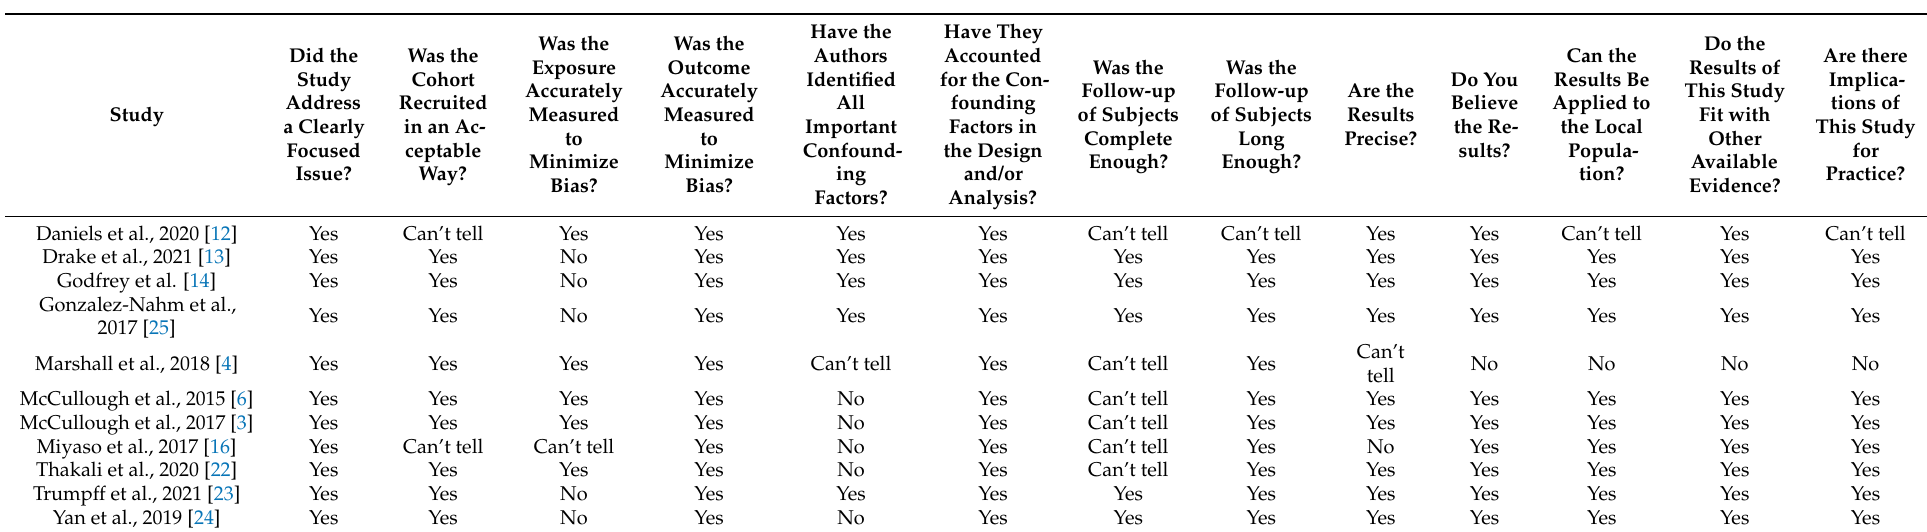
Table 3. Quality Assessment of Cohort Studies.